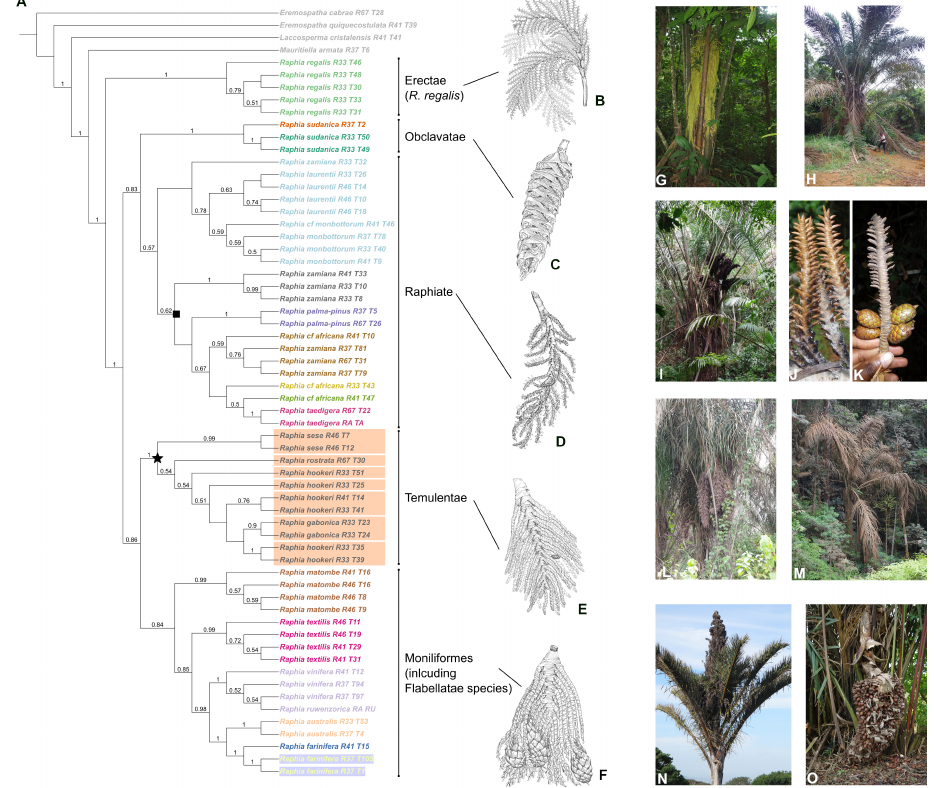
Figure 1. ( A ) Cladogram of the genus Raphia inferred using 85 gene trees and ASTRAL. Values of local posterior probabilities (LPP) equal or above 0.5 are shown above the branches. Branch lengths are represented in Figure A2. Individuals are color coded based on the hypothesis of species delimitation inferred using SODA with α = 0.01. For a single clade, the Temulentae section marked with a black star and referred to as the “hookeri“ complex in the main text, varied between the two values of α used here. The orange boxes represent the species limits using SODA with a more stringent value of α = 0.005. The black square shows the “zamiana“ complex clade. Tip names contain the species name as well as the sequencing ID. ( B ) R. regalis partial inflorescence representing the Erectae section (described here, see discussion). ( C ) R. sudanica inflorescence, representing the Obclavatae section. ( D ) R. palma-pinus inflorescence, representing the Raphiate section. ( E ) R. hookeri inflorescence, representing the Temulentae section. ( F ) R. farinifera inflorescence, representing the Moniliformes (and ex Flabellatae) section. ( G ) R. regalis , note the acaulescent habitat and inflorescences subtended by the leaves (Couvreur 398, Cameroon). ( H ) R. zamiana (Mogue Kamga 17, Gabon). ( I ) R. monbuttorum (Couvreur 1212, Cameroon), notice the semi-erect inflorescences. ( J ) detail of R. monbuttorum rachillae (Couvreur 1212, Cameroon). ( K ) detail of R. laurentii rachillae (Mogue Kamga 39, Democratic Republic of Congo). ( L ) R. hookeri (no voucher, Cameroon). ( M ) R. gabonica (Mogue Kamga